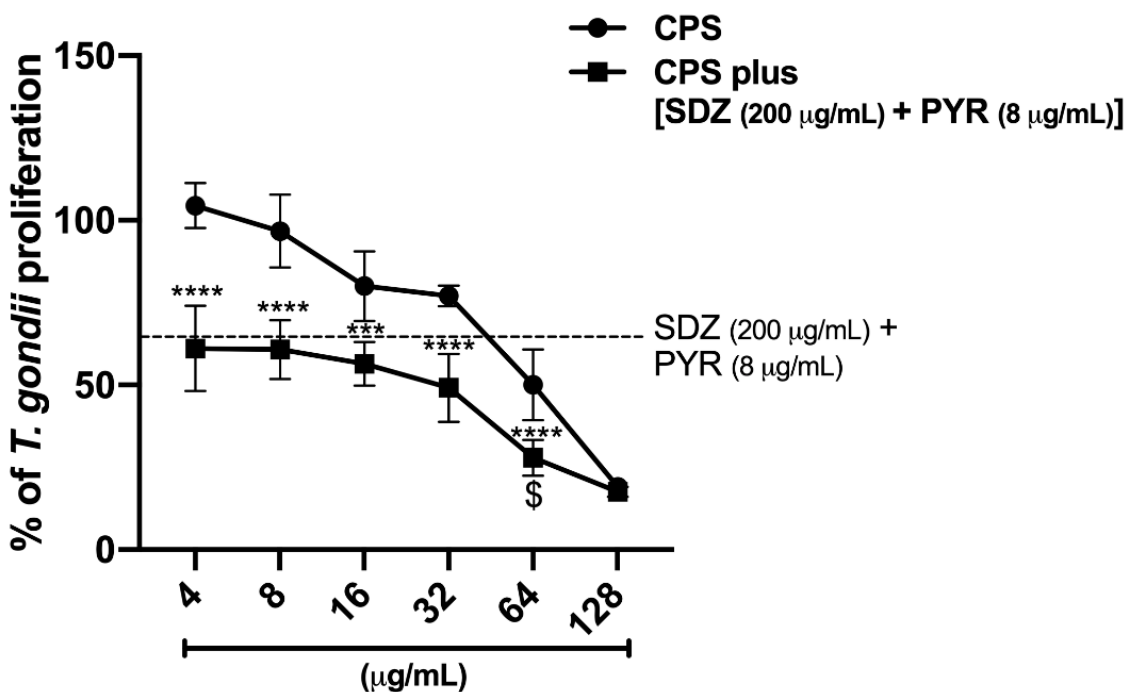
Figure 6. The effects of the association of CPS and SDZ + PYR to control intracellular parasite proliferation. Infected BeWo cells were treated with CPS (4 to 128 µ g/mL) alone or in the presence of SDZ + PYR (200 + 8 µ g/mL, respectively) for 24 h. Next, T. gondii proliferation was quantified by measuring β -galactosidase activity. Significant differences detected by the Kruskal–Wallis test and Dunn’s multiple comparison post-test are labeled (statistically significant when p < 0.05). * Comparison between CPS alone with CPS plus (SDZ + PYR). $ Comparison to both CPS alone and SDZ + PYR. $ p < 0.05, *** p < 0.001, **** p < 0.0001.